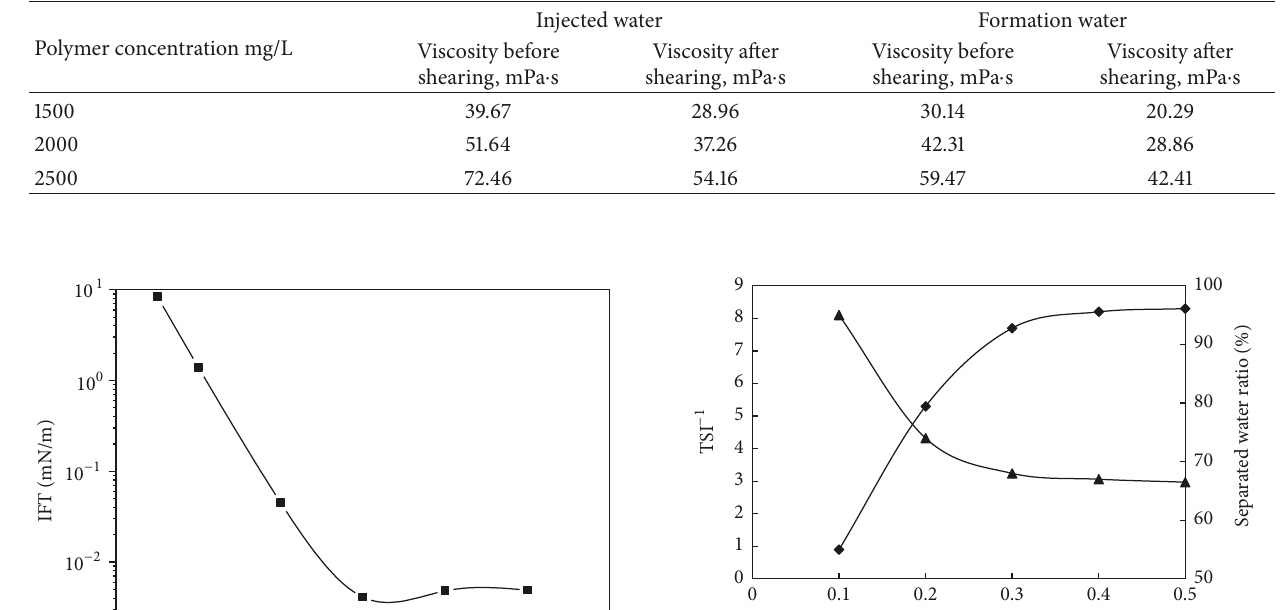
Table 3: The viscosity of the polymer solution under different conditions.